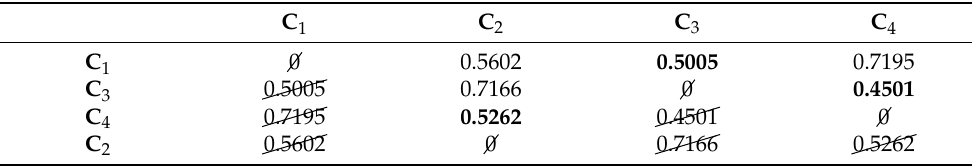
Table 4. Pairwise centroid-to-centroid distance based on Cartesian